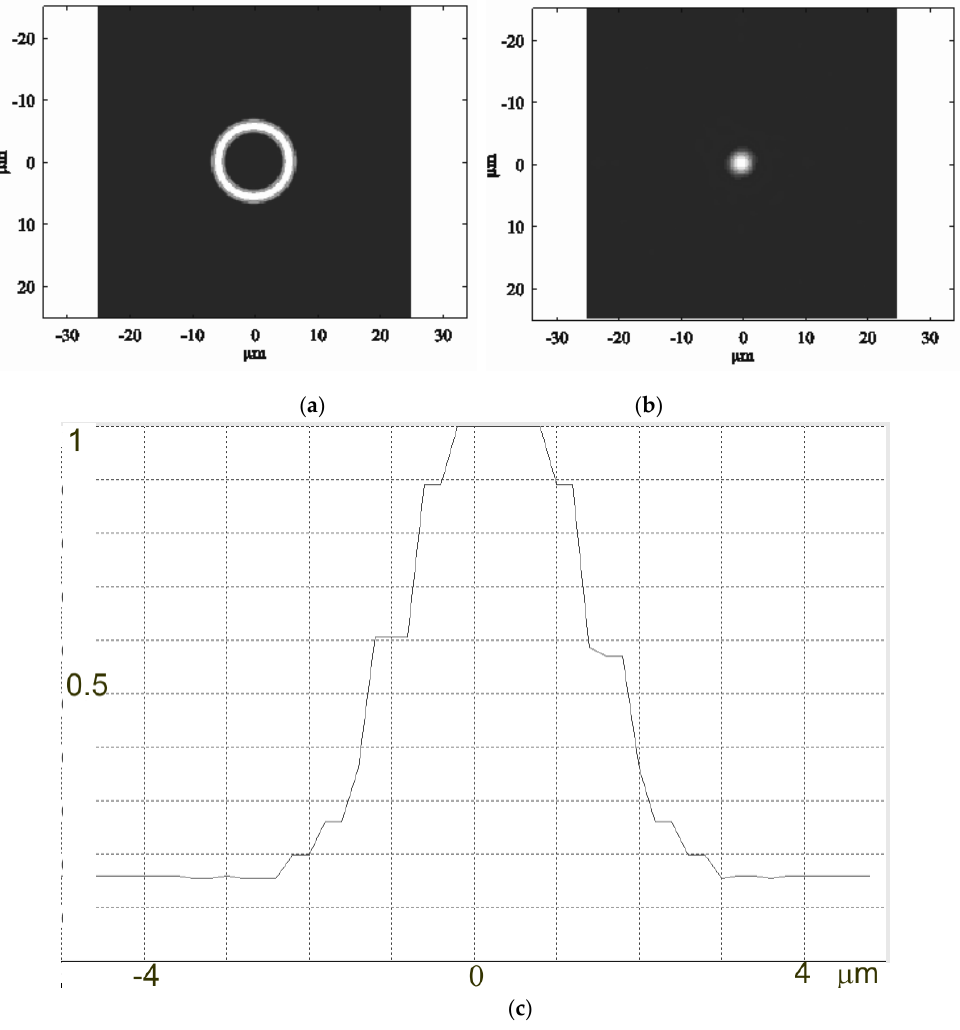
Figure 8. ( a ) A typical form of the intensity distribution on the recording surface outside the focal plane; ( b ) Point spread function (PSF); ( c ) PSF profile.